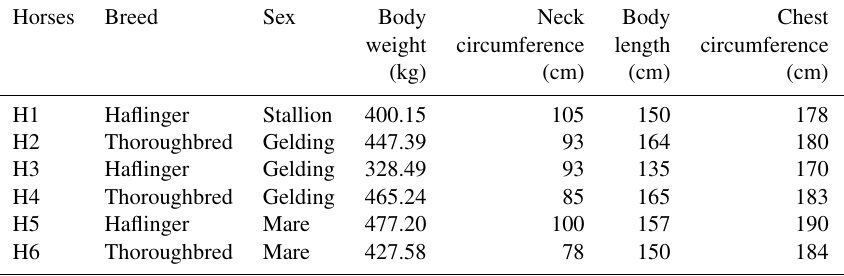
Table 2. The horses used in the study. Horses Breed Sex Body Neck